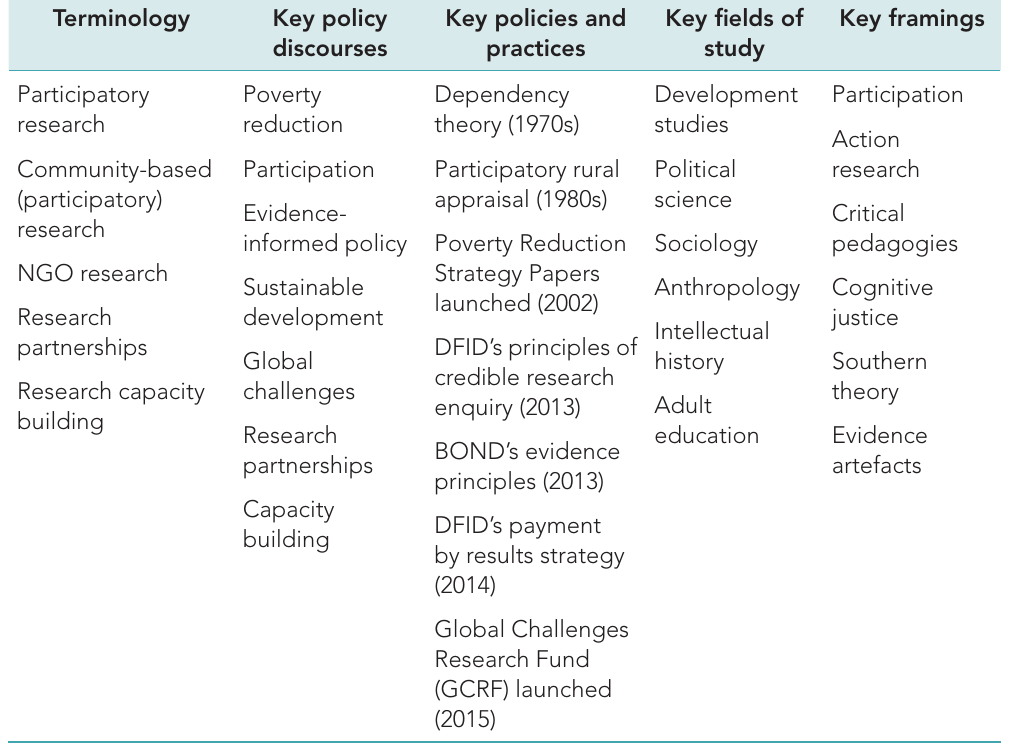
Table 4: Approaches to research engagement within the international development domain